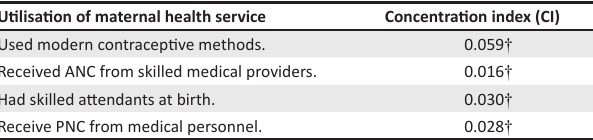
TABLE 5: Inequality in maternal healthcare service utilisation against income group of respondents. Utilisation of maternal health